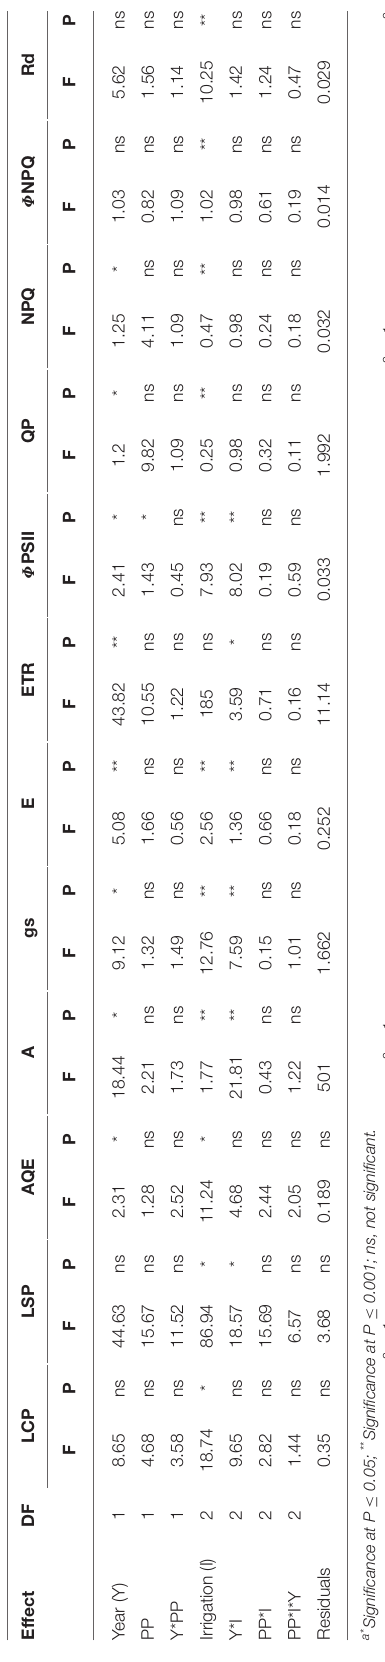
Figure 3 shows light response curves (assimilation rate vs. the photosynthetic photon flux density, PPFD) for cotton in the vegetative stage (V6) and reproductive stage (C5) for all the irrigation and planting geometry combinations for both seasons. Cotton plants exhibited a significantly higher CO 2 assimilation rate under irrigated conditions (AFI and SFI) than in a rainfed situation in both the vegetative and reproductive stages ( Figure 3 ). No differences were observed among SR and TR plantings for CO 2 assimilation rate. The TR pattern recorded a 23% increased plant population per unit area over the SR system, which probably has contributed to a 15% lint yield advantage in spite of similar assimilate rates (Pinnamaneni et al., 2020a). Like soybean, the CO 2 assimilation rate plateaued under light saturation conditions at 1500 µ mol m − 2 s − 1 in cotton. The results of this study echo the observations of Massacci et al.